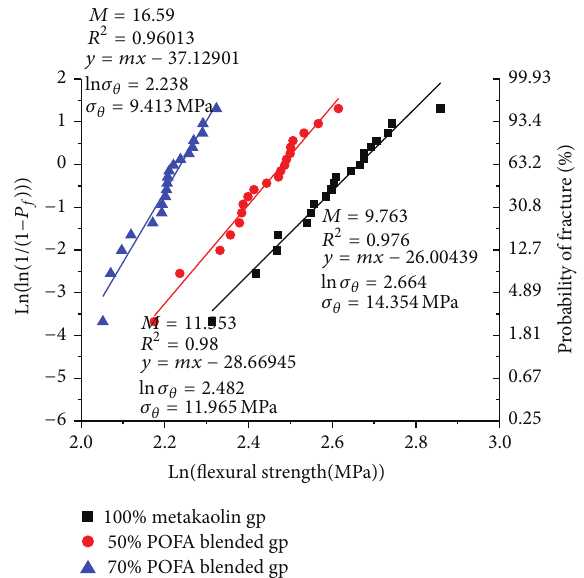
Figure 2: Weibull graph of flexural strength of blended geopolymer.